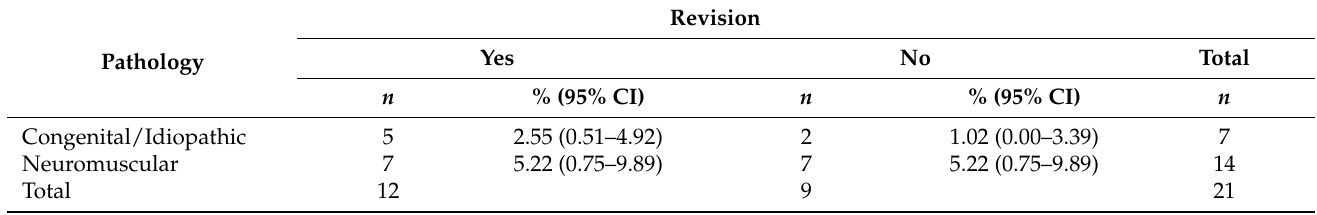
Table 4. Association between neuromuscular scoliosis and necessity of surgical